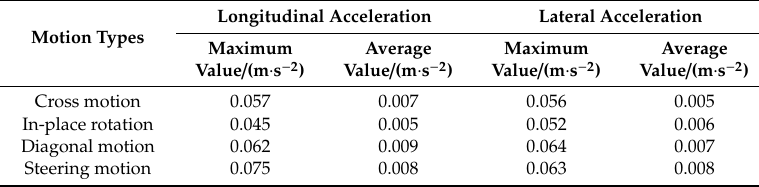
Table 3. Longitudinal and lateral acceleration of the flexible chassis centroid.